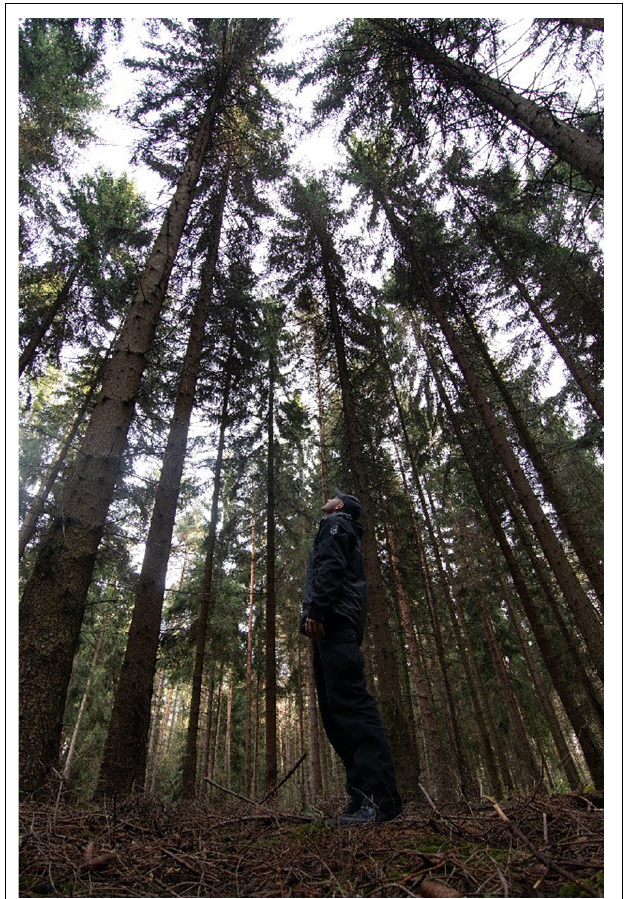
FIGURE 10 | Merging with the forest (source: Instagram/@ak_hobbyphoto/Adrian Kühnel).